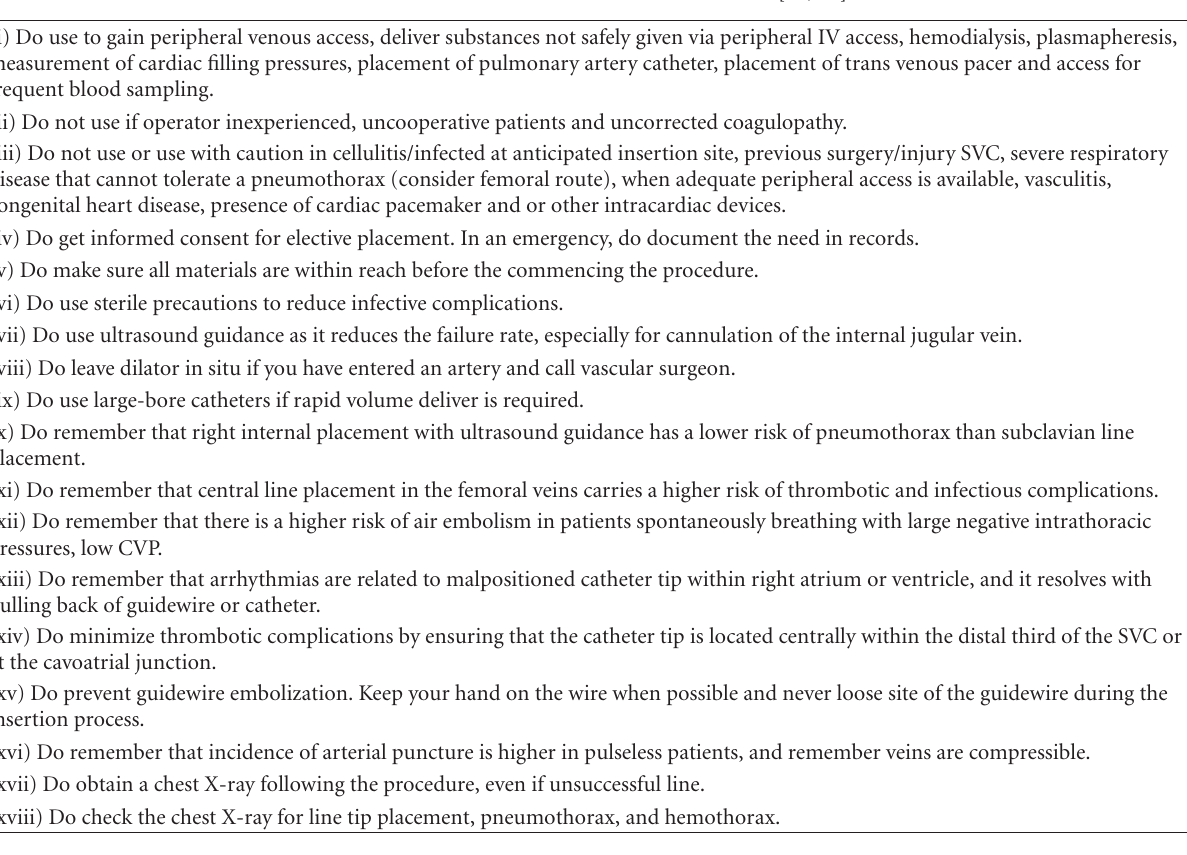
Figure 35: The NGT has entered the main right lobe bronchus in two patients. The patient in (b) already had left basal pneumonia; delivery of fluids down the right lower lobe bronchus would have resulted in disastrous consequences of the position of the NGT that had gone unrecognized. Table 1: Central venous lines do’s and donot’s [28,